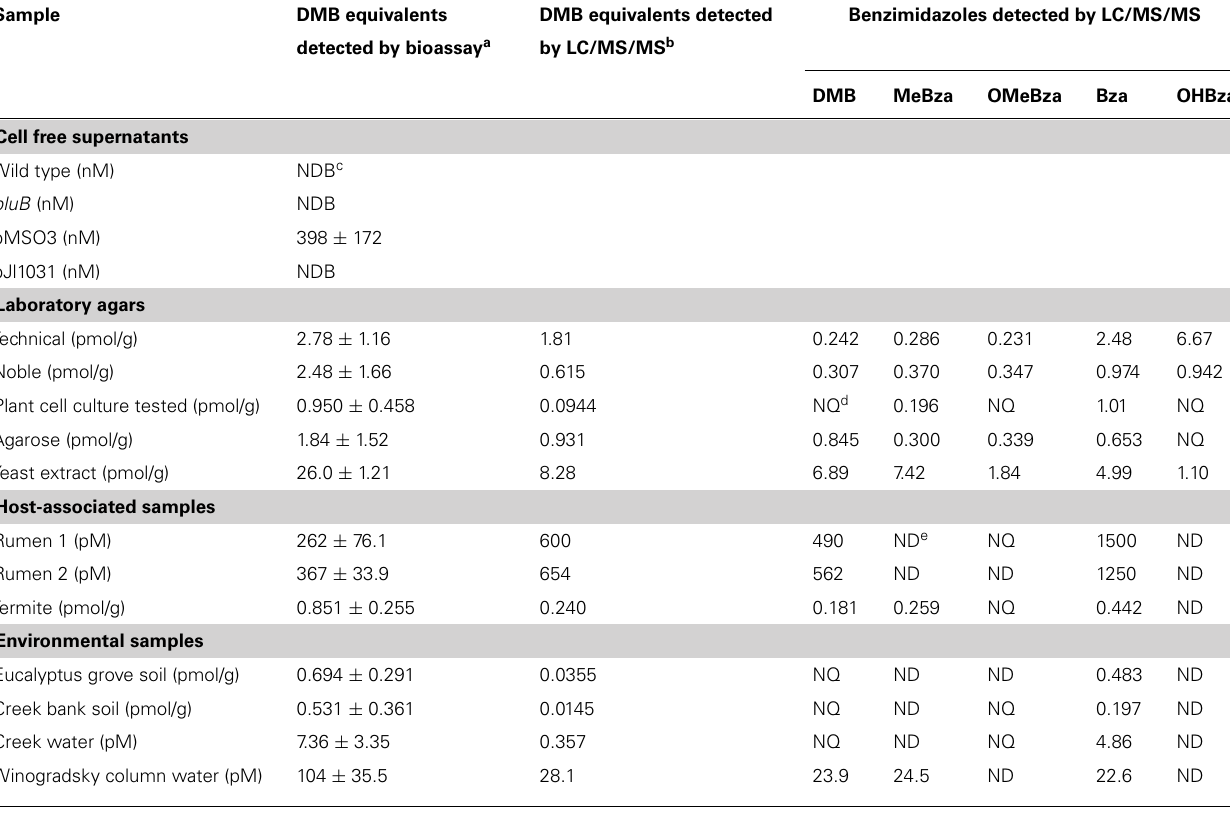
Table 2 | Benzimidazole levels in environmental samples as determined by the S. meliloti calcofluor bioassay and LC/MS/MS.